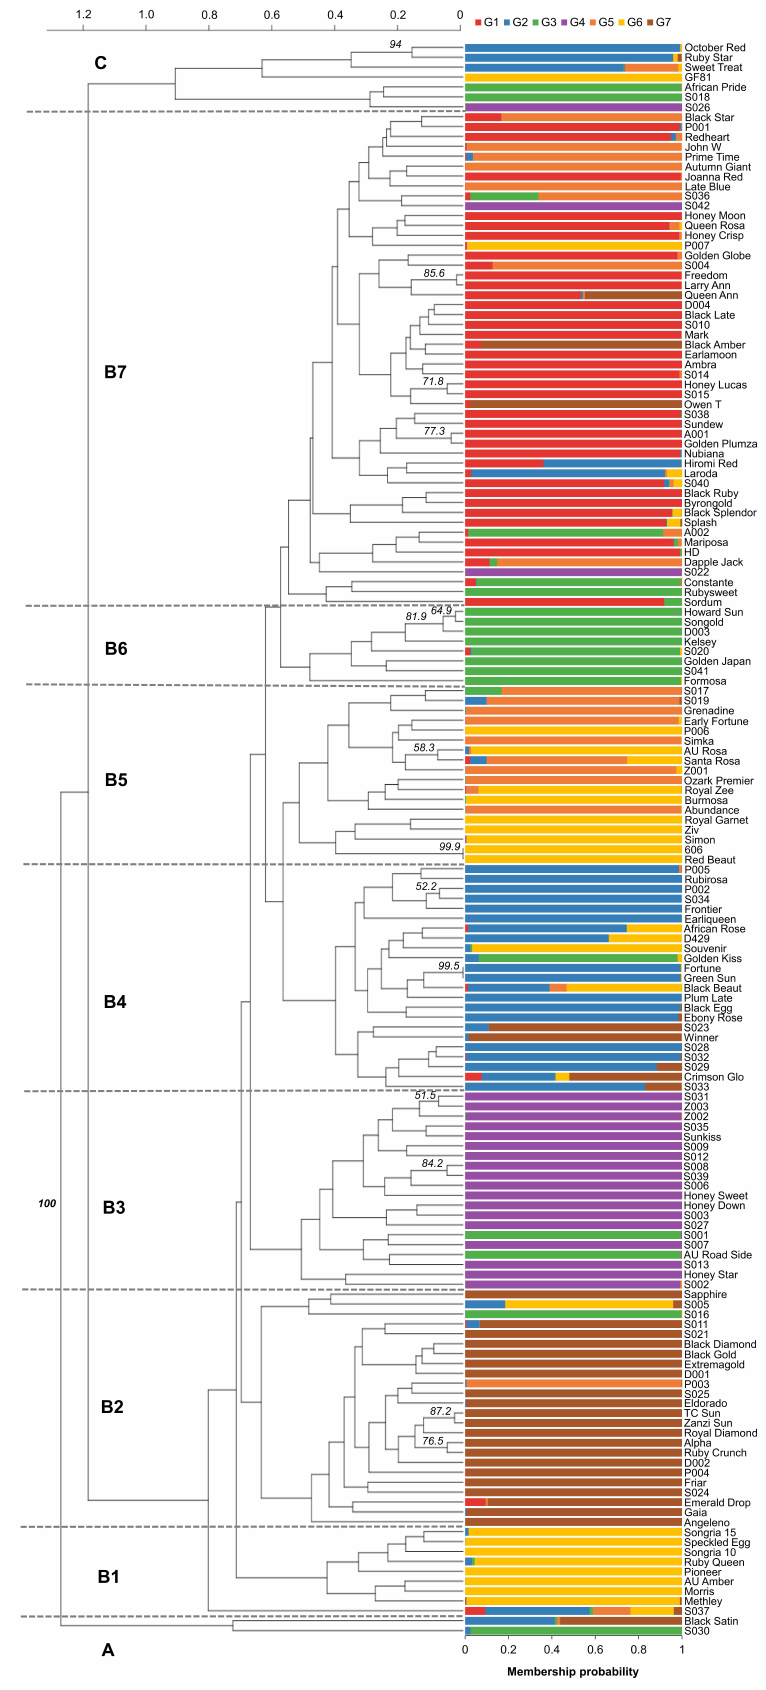
Figure 1. Genetic relationships and genetic structure from 161 Japanese plum-type accessions